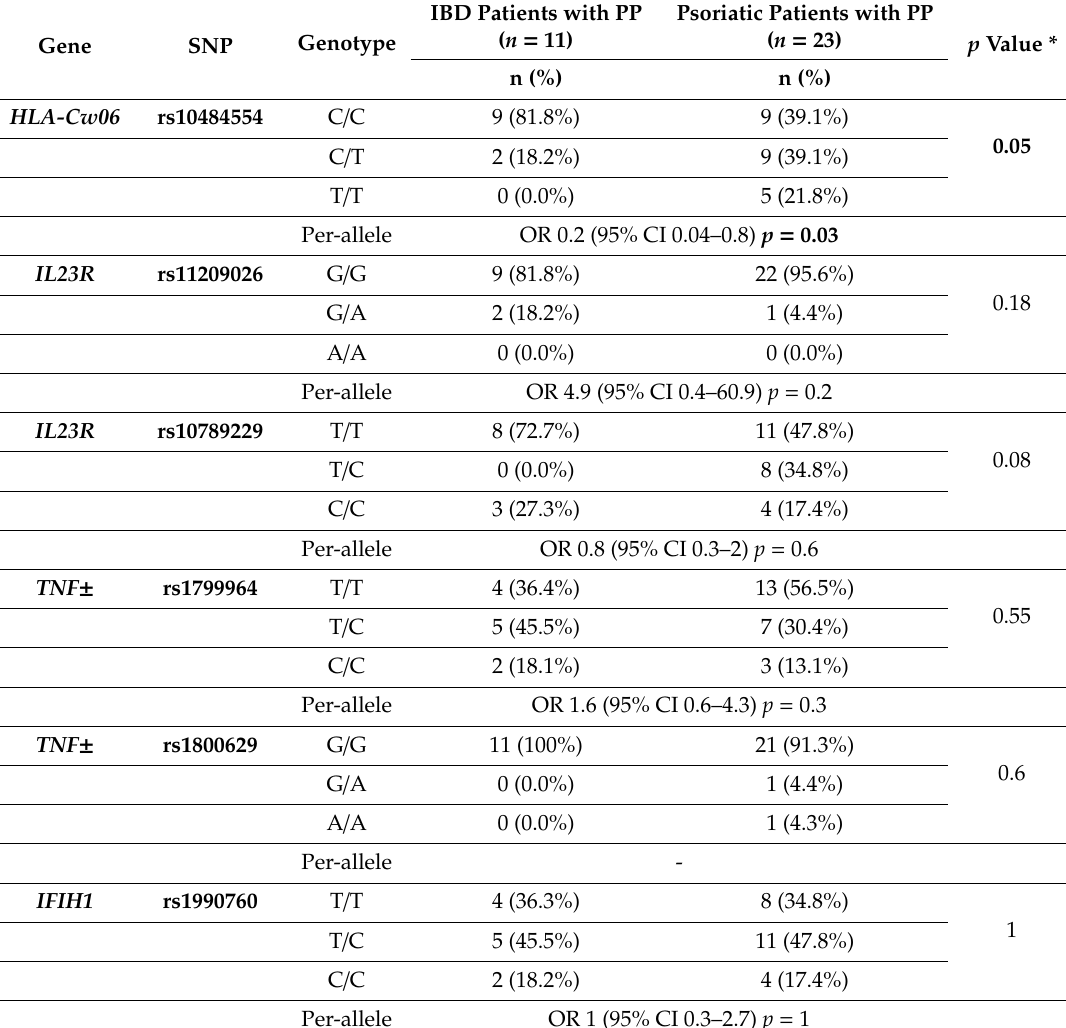
Table 5. Distribution of IBD and psoriatic patients with PP treated with adalimumab according to the genotype frequencies of the six SNPs